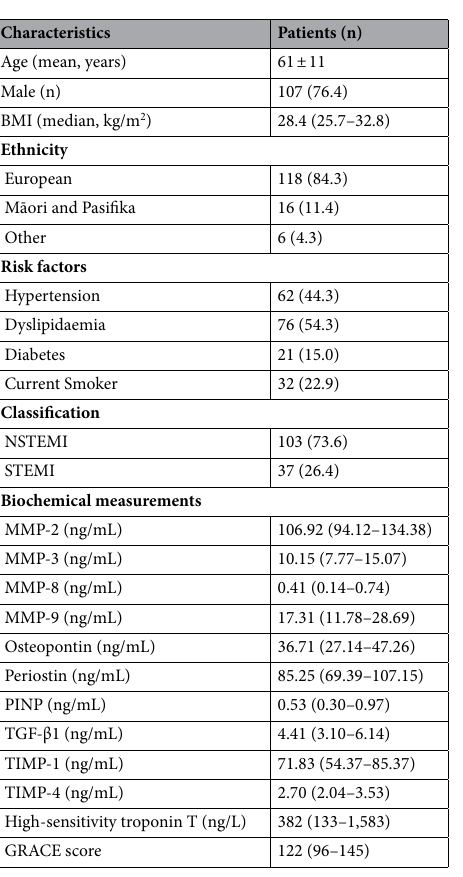
Table 1. Baseline demographics of the study population. Parametric continuous variables were expressed as mean ± SD and non-parametric continuous variables were expressed as median (IQR). Categorical